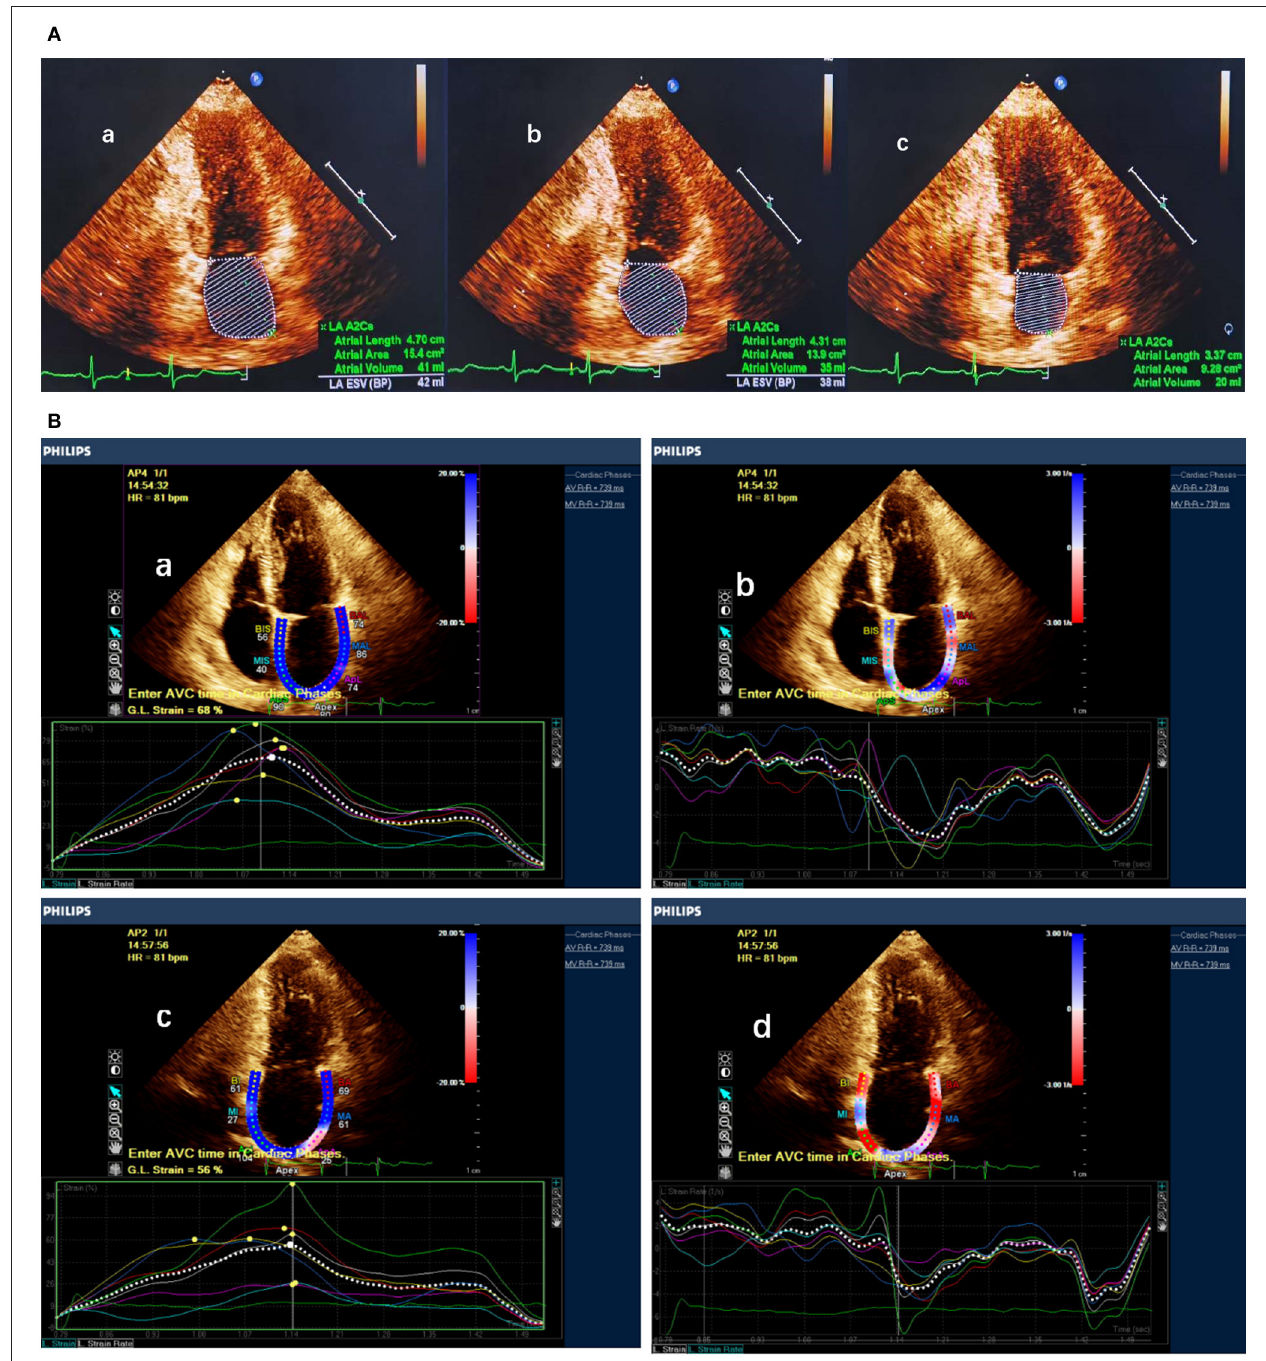
FIGURE 3 | LA function measured by LA volume and speckle tracking echocardiography. (A) Measurement of maximum LA volume, before atrial contraction LA volume and minimum LA volume. (B) Measurement of LA strain and strain rate in apical two- and four-chamber view. a,b Atrial strain and strain rate measured in apical four-chamber view. c,d Atrial strain and strain rate measured in apical two-chamber